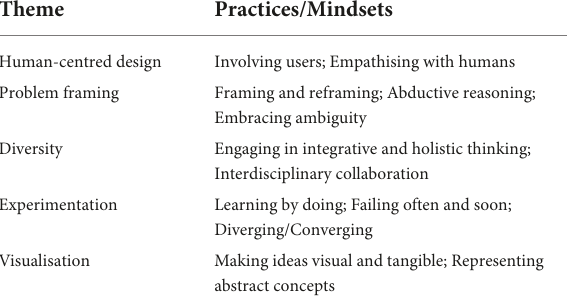
Theme Practices/Mindsets Human-centred design Problem framing